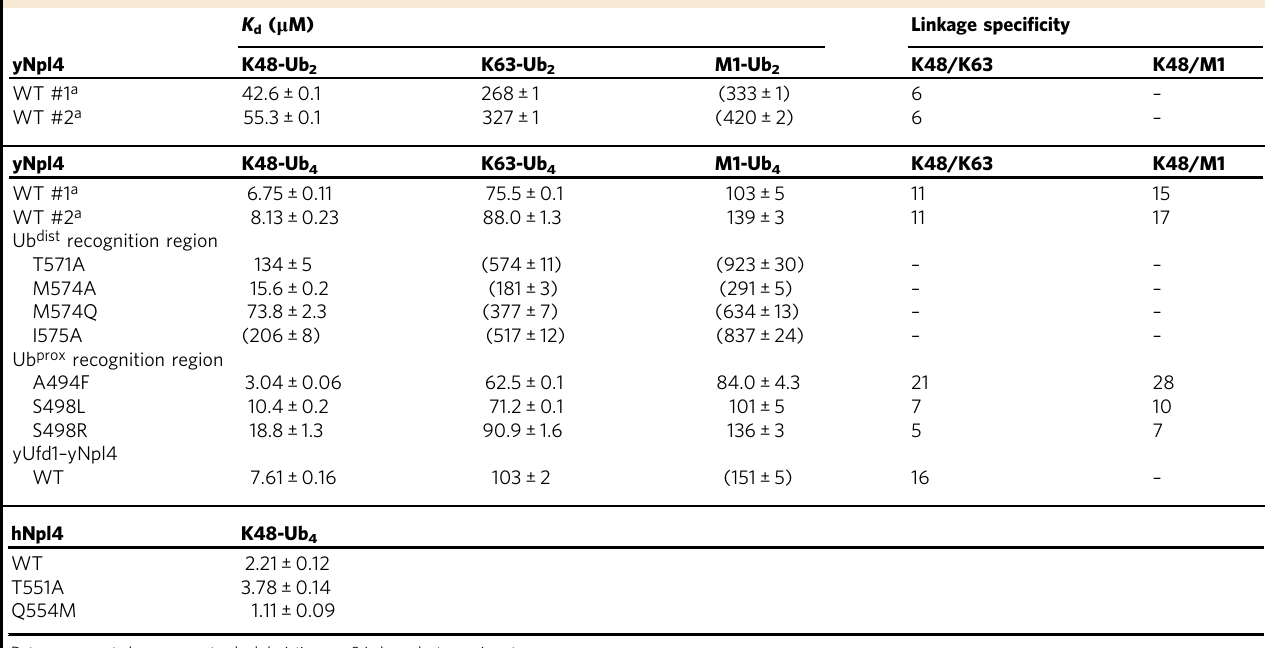
Table 2 Binding af fi nity of Npl4 for K48, K63, or M1